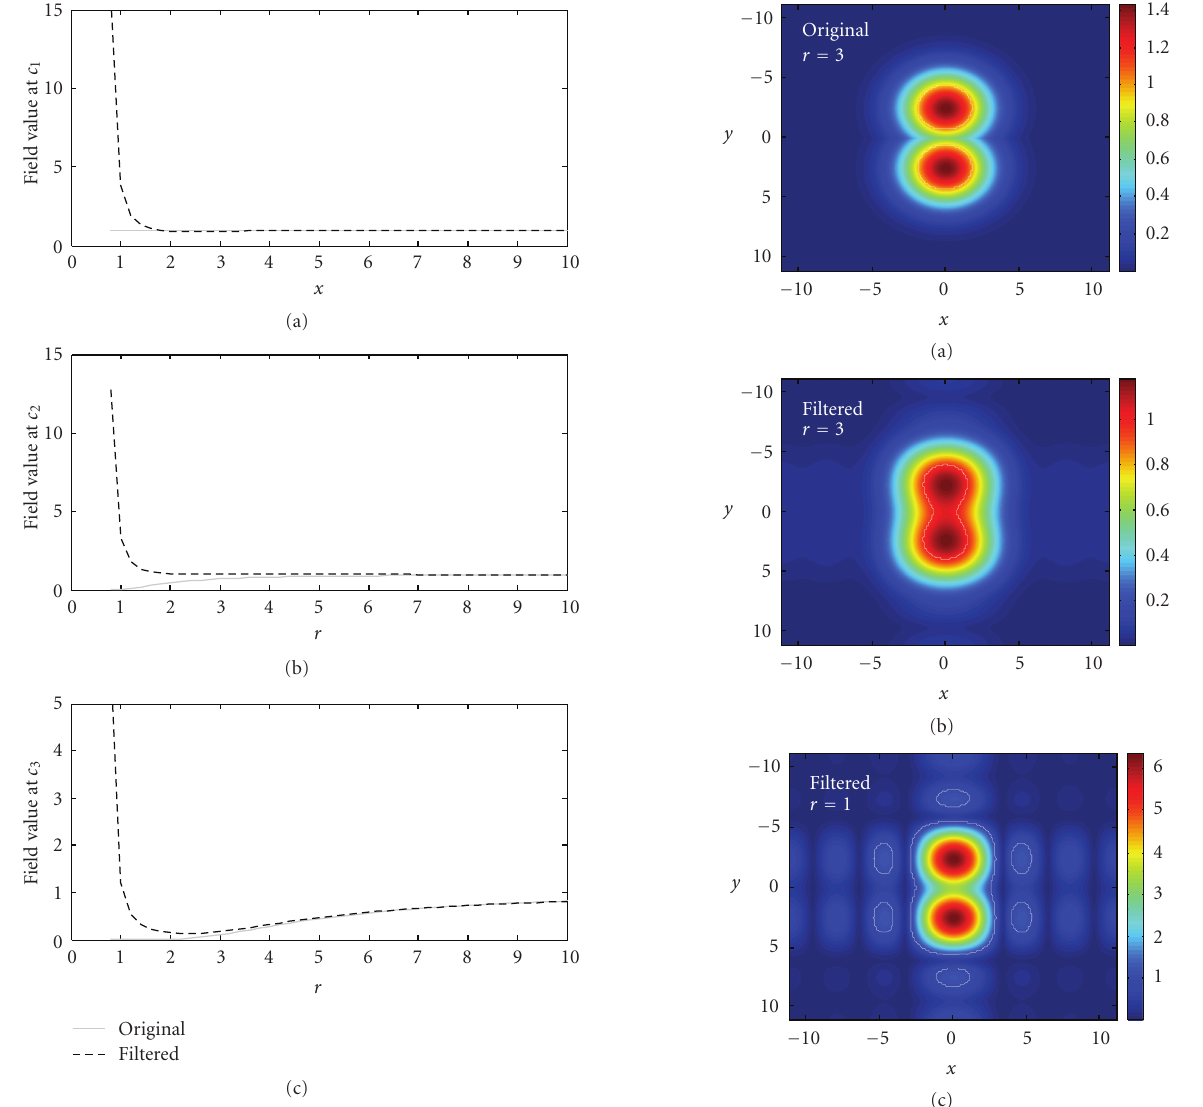
Figure 6: Value of the density map for the example of Figure 4. x and y are the two spatial dimensions ( ˚ A) and the colors represent the value of the density map before filtering and with r = 3 (a) after filtering and with r = 3 (b) and after filtering with r = 1 (c). The contour for t = 1 is depicted with a white line. It represents the VdWS (a), the SES (b), and the SES with artifacts